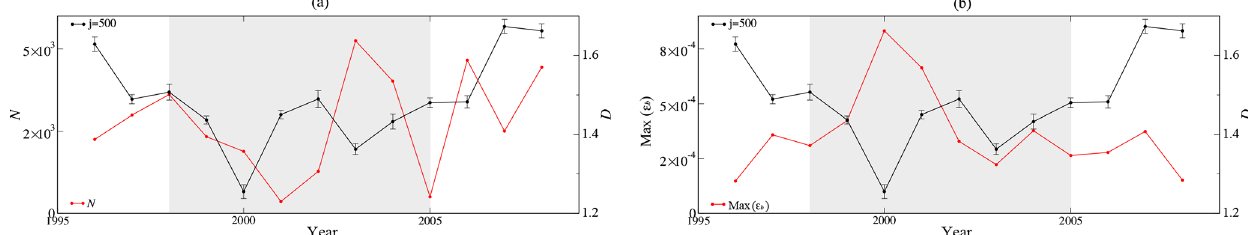
Figure 8. Box-counting dimension of magnetic forcing term for j = 500 with respective activity of (cid:15) b (t) (red lines): N (a) and max ((cid:15) b ) (b) , with n = 5. The grey region corresponds to the maximum period of the solar cycle, as described in the text.